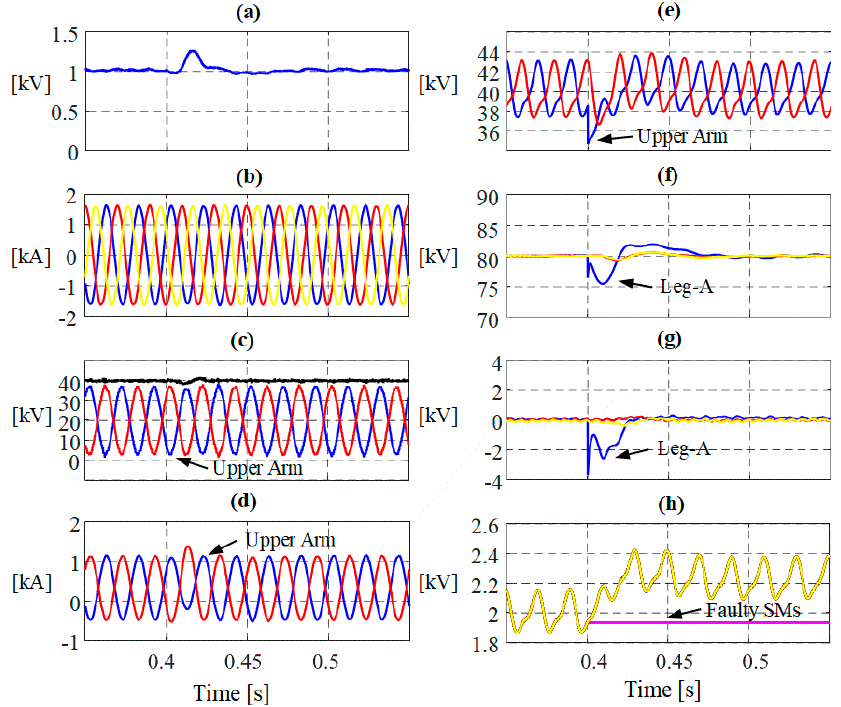
Figure 8. Simulation waveforms of the MMC under submodule (SM) fault and control scheme-A operates in active power mode: ( a ) dc current, ( b ) ac current, ( c ) leg A upper and lower arm voltages